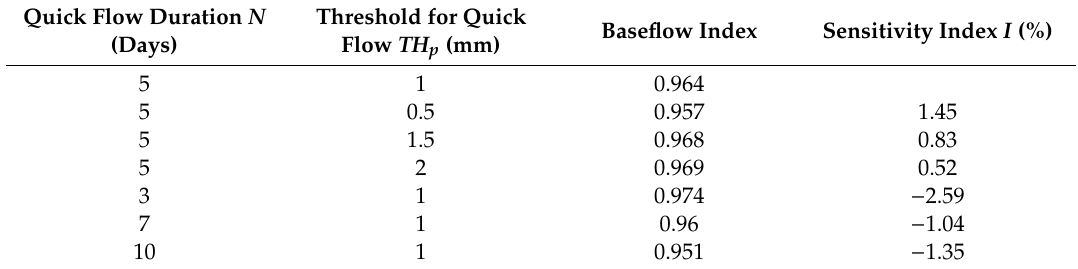
Table 4. Results of the sensitivity analysis for